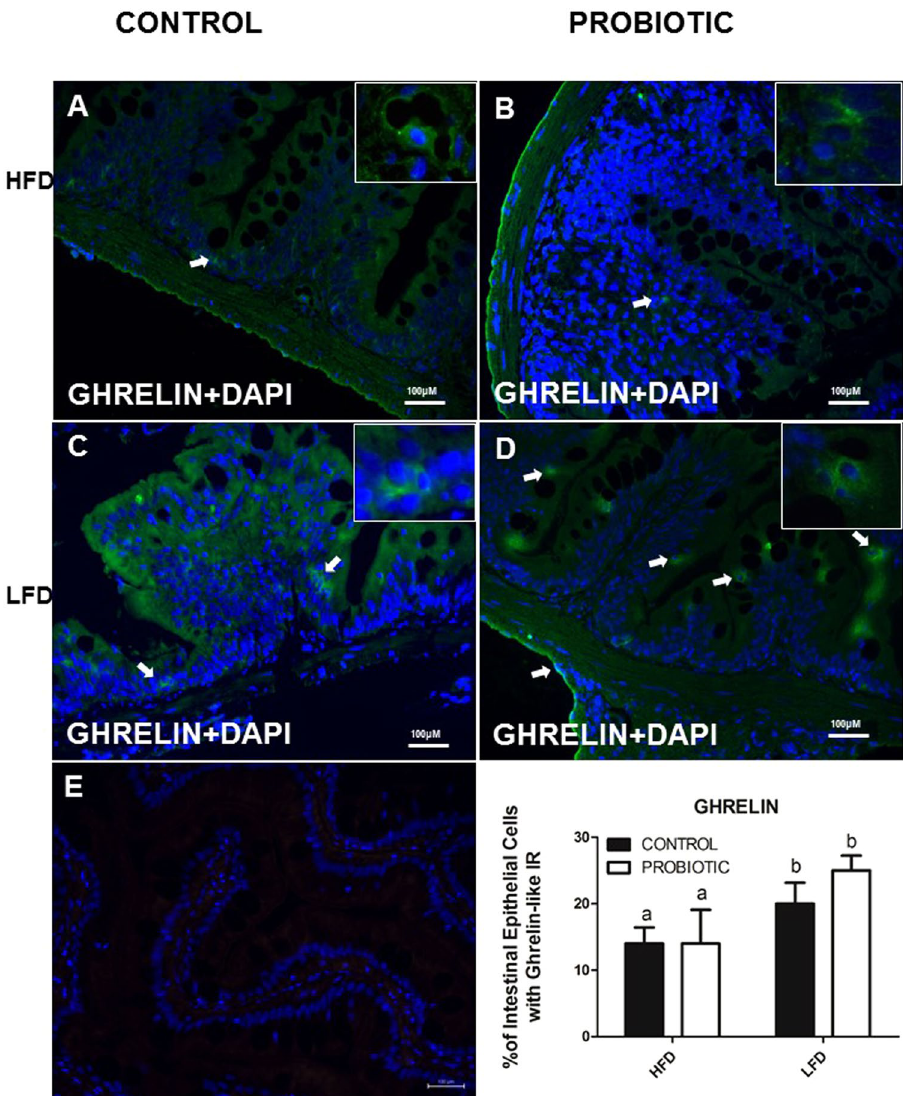
Figure 4. Ghrelin-like ir in the gut of zebrafish fed with HDF-P and HFD-C compare to LFD-C. Ghrelin positive cells did not show changes in the intestine of fish fed a LFD-C (4C) compare to LFD-P (4D) and HFD-C (4A) compare to HFD-P (4B). For details on methods employed for percentage of positive intestinal epithelial cells calculation, please consult the Materials and Methods section. Values with different superscript letters are significantly different ( p <